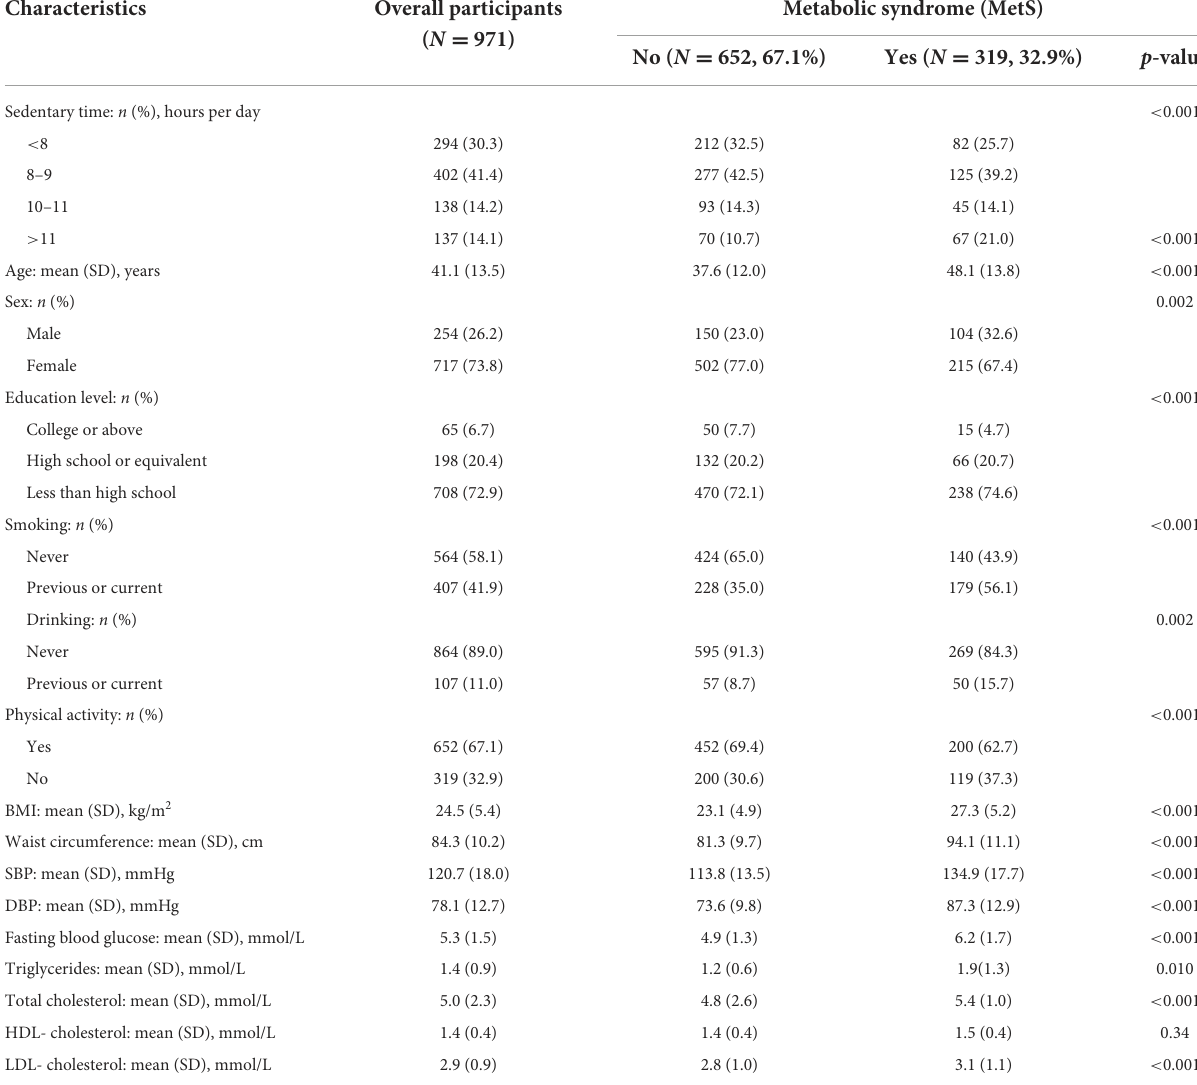
TABLE 1 Characteristics of the overall study participants and by metabolic syndrome.